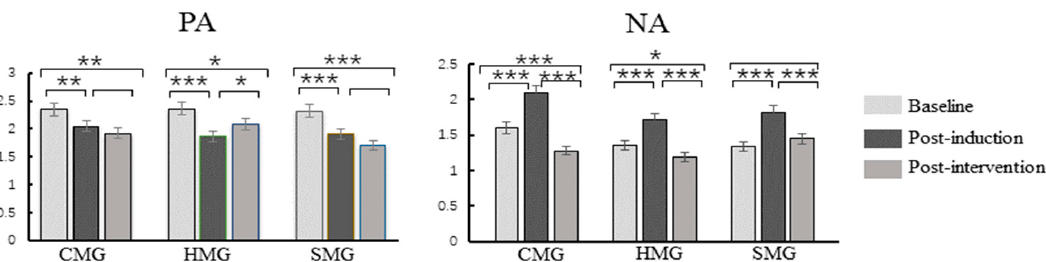
Figure 3. Positive and Negative Affect Schedule (PANAS) difference within-group before and after measure of the face–word Stroop task. PA: positive affect, NA: negative affect; CMG: calm music group, HMG: happy music group, SMG: sad